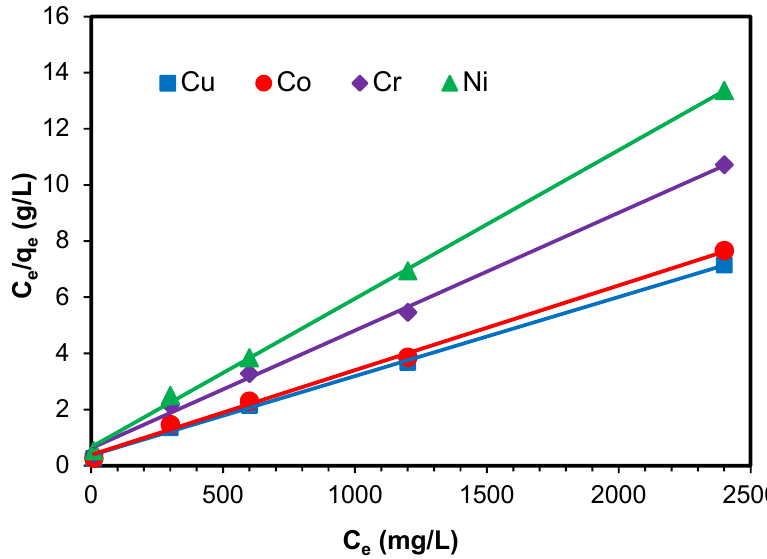
Figure 13. Linear plots of Langmuir adsorption isotherm by poly(hydroxamic acid) ligand; experi- mental conditions: 100 mg of poly(hydroxamic acid), 5 mL of 0.1 M CH 3 COONa buffer solution, and 5 mL of 0.1 M heavy metal solutions (10, 300, 600, 1200 and 2400 ppm) at pH 6 agitated for 2 h.